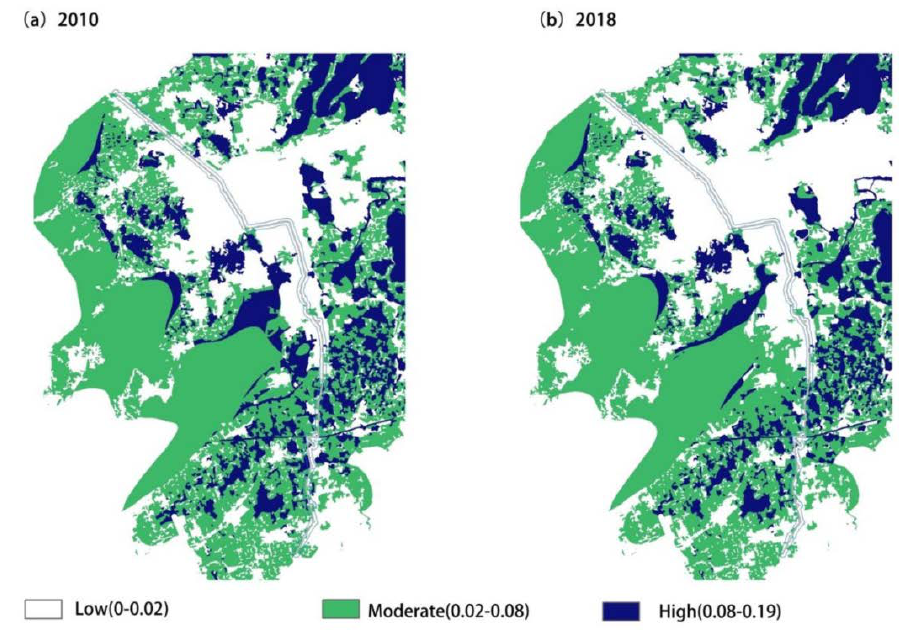
Figure 9. Equal interval habitat degradation grading map of study area between 2010 and